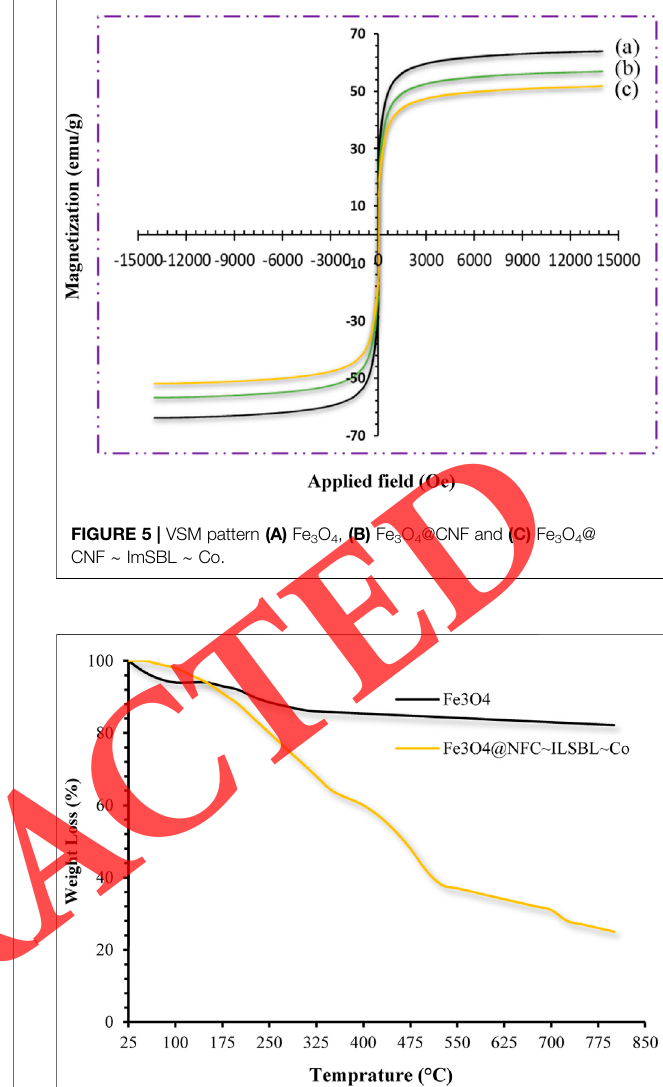
FIGURE 6 | TGA curves for (black line) Fe 3 O 4 , and (yellow line) Fe 3 O 4 @CNF ∼ ImSBL ∼